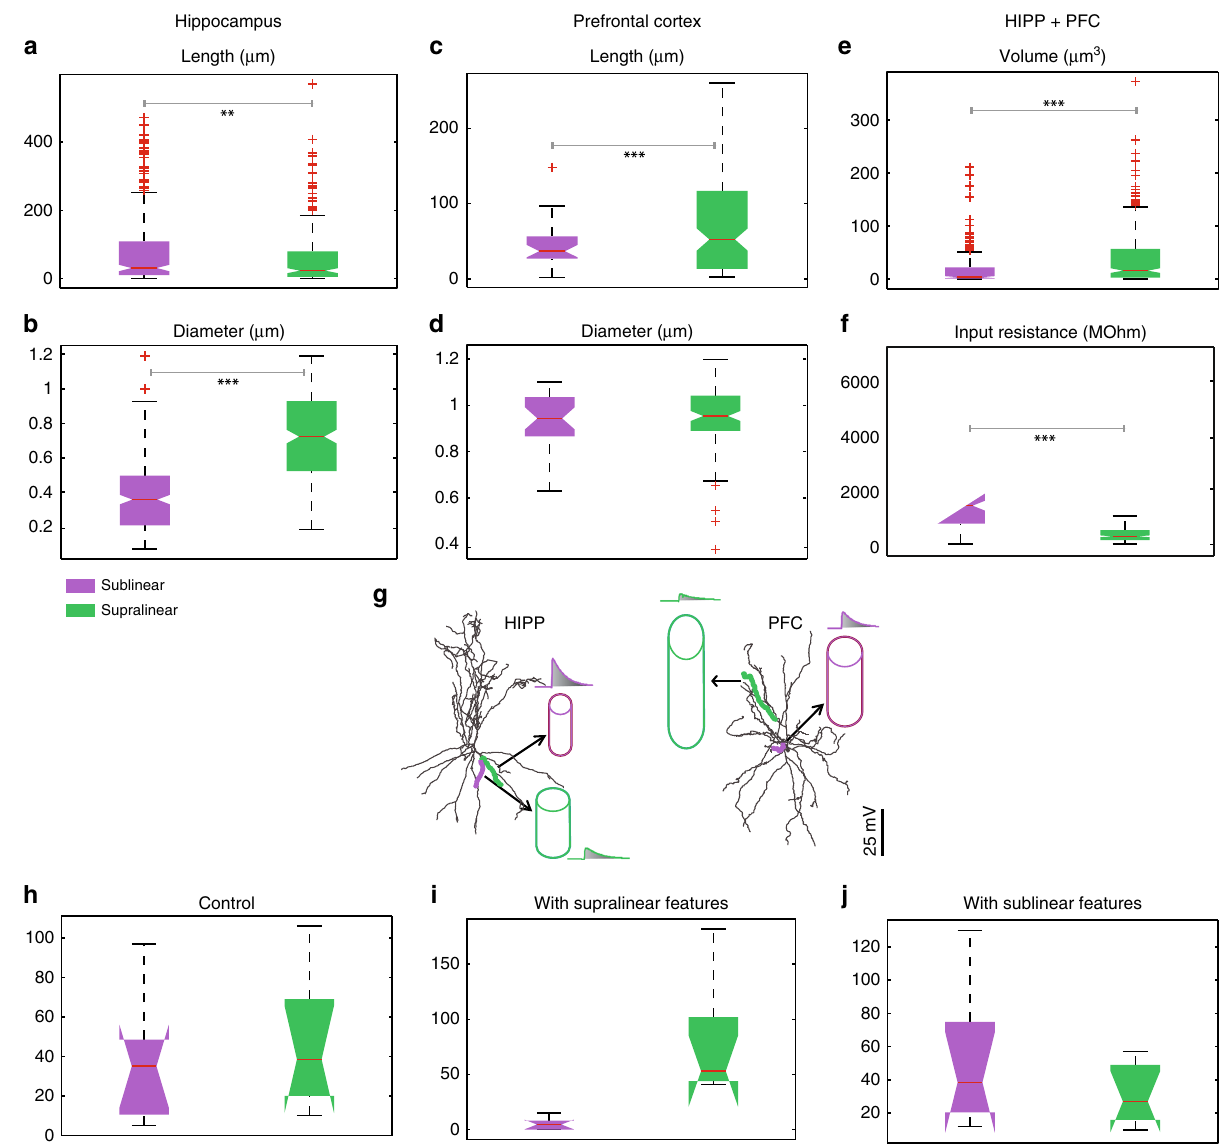
Fig. 3 Morphological determinants of dendritic integration mode. a , c Total length distributions of supralinear vs. sublinear dendrites in the hippocampus ( a ) and the PFC ( c ). Statistically signi fi cant differences are observed for both sub- and supra-linear dendrites, in both areas. ( p -value < 0.0001 for hippocampus and p -value < 0.01 for PFC, Student's t -test). b , d Same as in a , b , for mean dendritic diameter. Statistically signi fi cant differences are observed in hippocampal ( p -value < 0.0001 Student ’ s t -test) but not in PFC FS BCs. e , f . Dendritic Volume and dendritic Input resistance are common discriminating characteristics among supralinear (larger, with low input resistance) and sublinear (smaller, with high input resistance) dendrites, for both areas ( p -value < 0.0001 Student ’ s t -test for hippocampus and PFC, for Volume and Input resistance respectively). g Schematic illustration of morphological features for supralinear and sublinear dendrites in hippocampus (left) and PFC (right). Traces indicate the fi rst EPSP in supralinear and sublinear